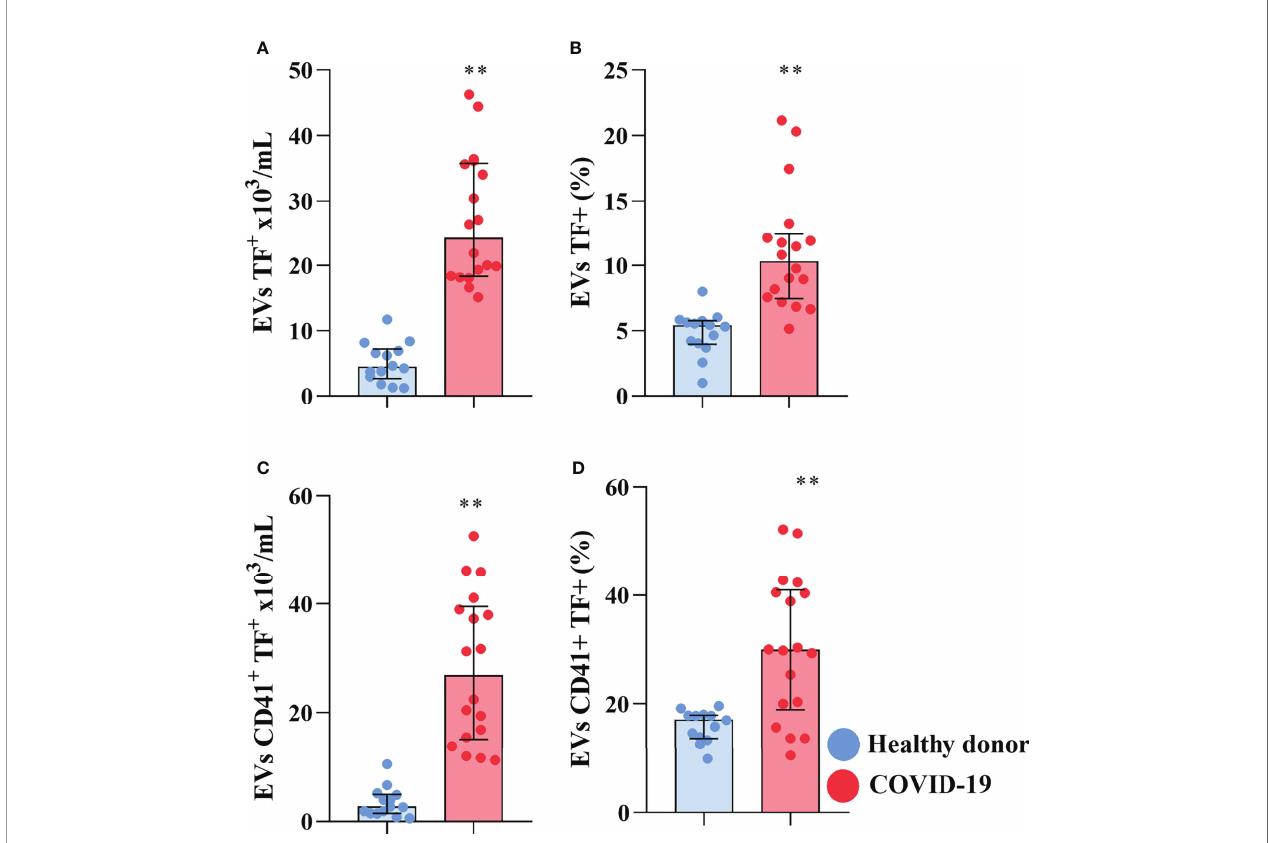
FIGURE 2 | Severe COVID-19 patients present increased circulation of pro-coagulant TF-bearing EVs. The concentration (A) and percentage of EVs expressing TF (B) . The concentration (C) and percentage of platelet derived EVs expressing TF (D) . Medians with interquartile range are shown. Individual values for healthy donors (blue dots) and COVID-19 patients (red dots) are shown. **p<0.001.